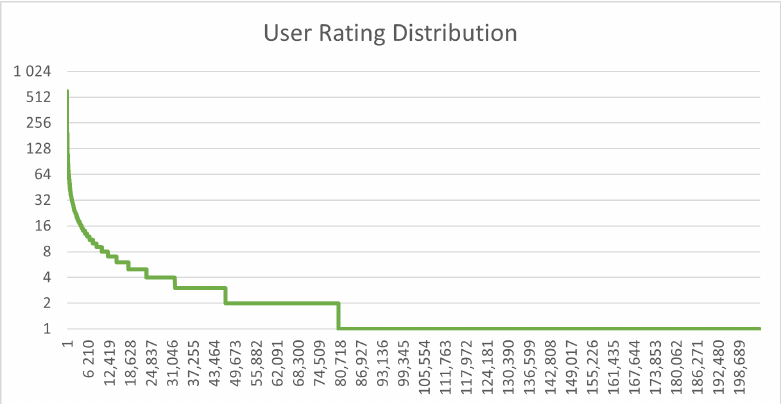
Figure 3. The user rating distribution (Phoenix). The X axis represents the numerical user IDs starting from 1. For example, if we have 10 users, they will be numbered from 1 to 10. The Y axis is the number of ratings they have left and it is on log scale to show a clearer distribution.